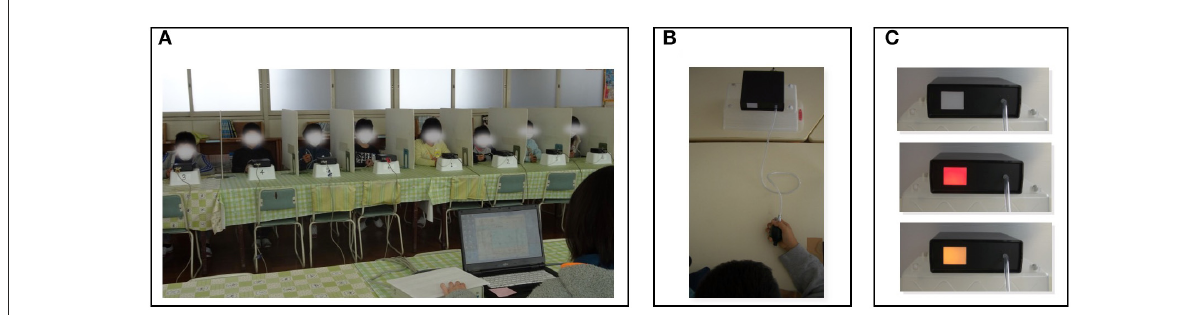
FIGURE1 The go/no-go task in this study. The experiment was conducted in groups of up to 12 participants; (A) A stimulator was placed in front of each participant, and their responses were collected from grasping the rubber balls; (B) Go trials were a red light for elementary school children or a bright light for junior high school children; no-go trials were a yellow light for elementary school children or a dark light for junior high school children; (C) Both trials consisted of 11 phases, totalling 22